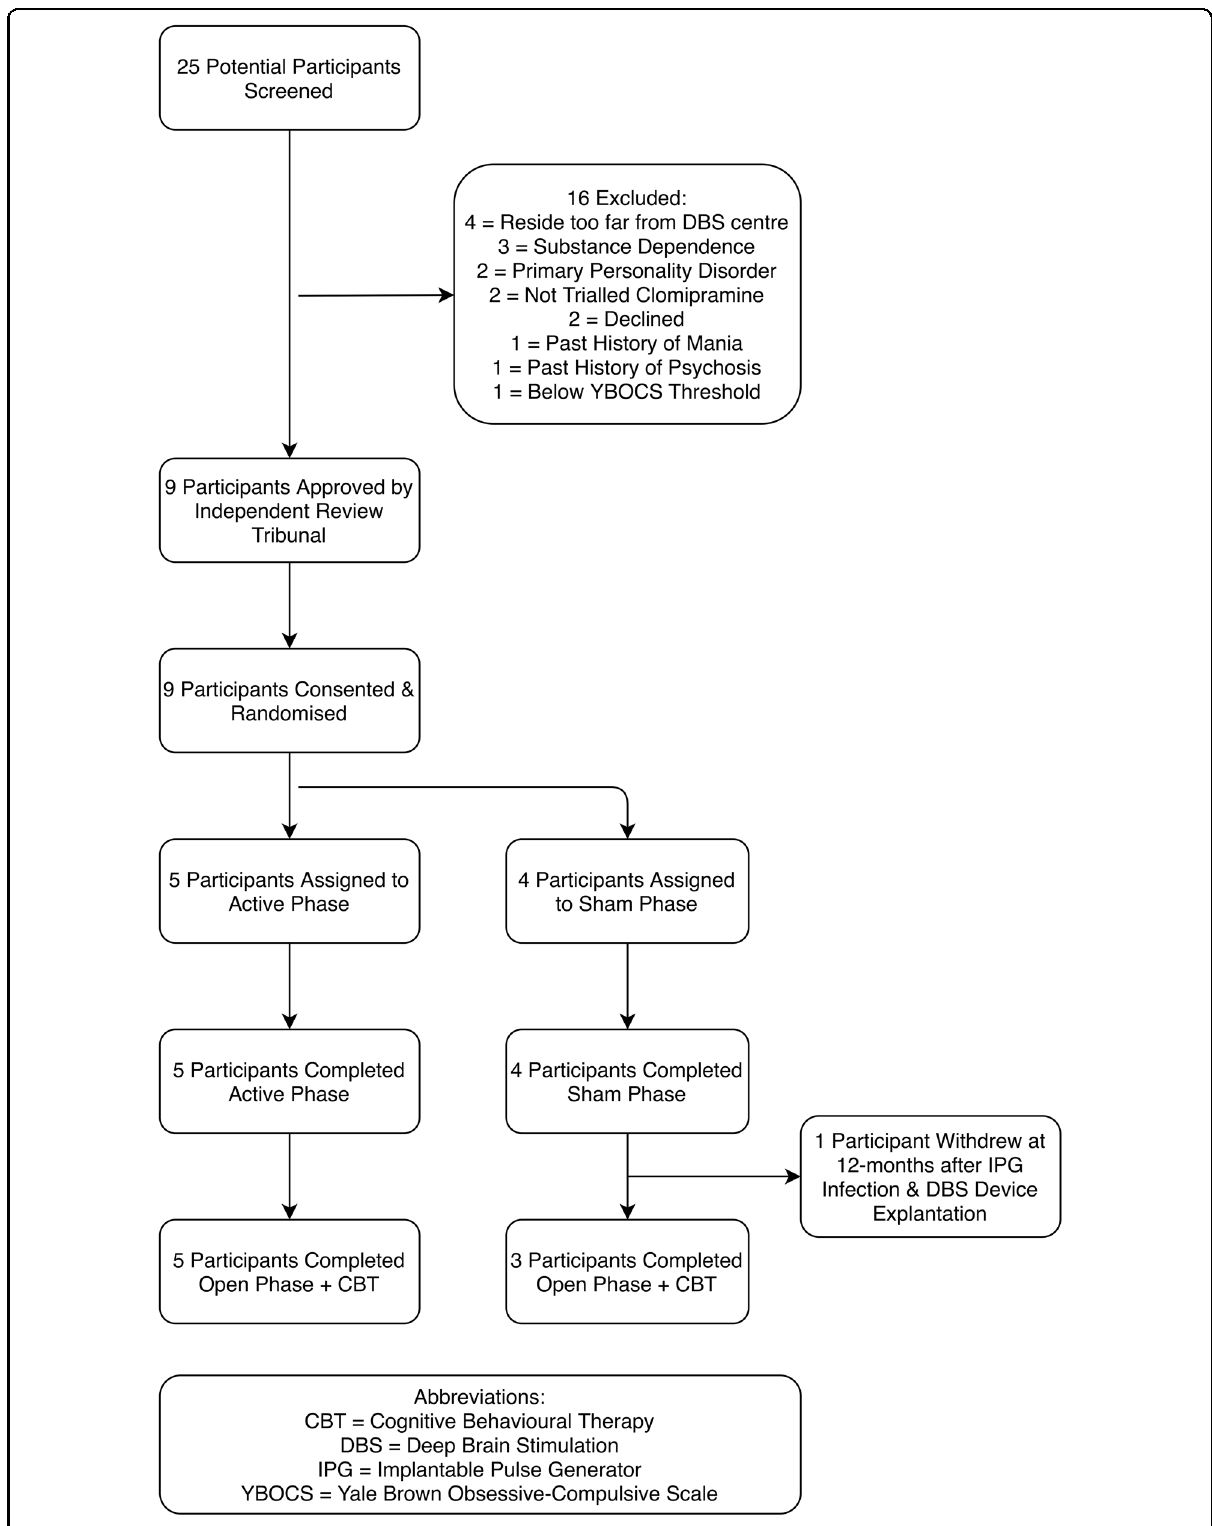
Fig. 1 Flow diagram of participant recruitment, randomisation and